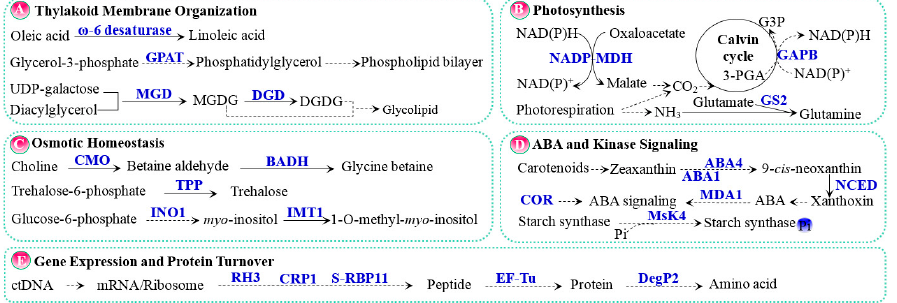
Figure 2. Salt tolerance pathways in chloroplasts. ( A ) Thylakoid membrane organization; ( B) Photosynthesis; ( C ) Osmotic homeostasis; ( D ) ABA and kinase signaling; ( E ) Gene expression and protein turnover. The solid line indicates a single-step reaction, and the dashed line indicates a multistep reaction. Substrates and products are in black font, proteins are in blue bold font, and P in a blue circle indicates phosphorylated protein. Abbreviations: 3-PGA, glycerate-3-phosphate; ABA, abscisic acid; ABA1, zeaxanthin epoxidase; ABA4, neoxanthin synthase; BADH, betaine aldehyde